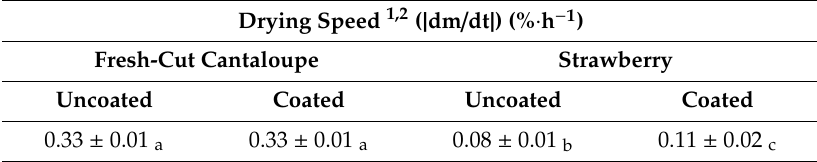
Table 1. Average drying speed ( | dm / dt | , % · h − 1 ) (boundary conditions; t 1 = 0 h and t 2 = 235 h) of coated and uncoated strawberries and fresh-cut cantaloupes at 10 ◦ C during gradual relative humidity (RH) decrease (80% → 60% RH) ( n = 4). (Coating solution: 1.25% alginate + 2 glycerol + 0.2% sunflower oil +